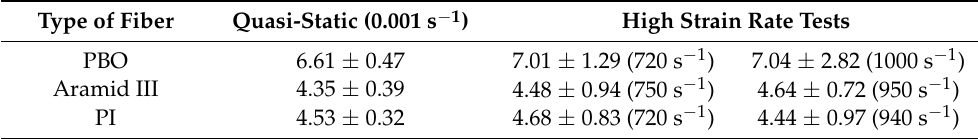
Figure 4. Dynamic tension process. Table 2. Strength (in GPa) of the three fibers at each strain